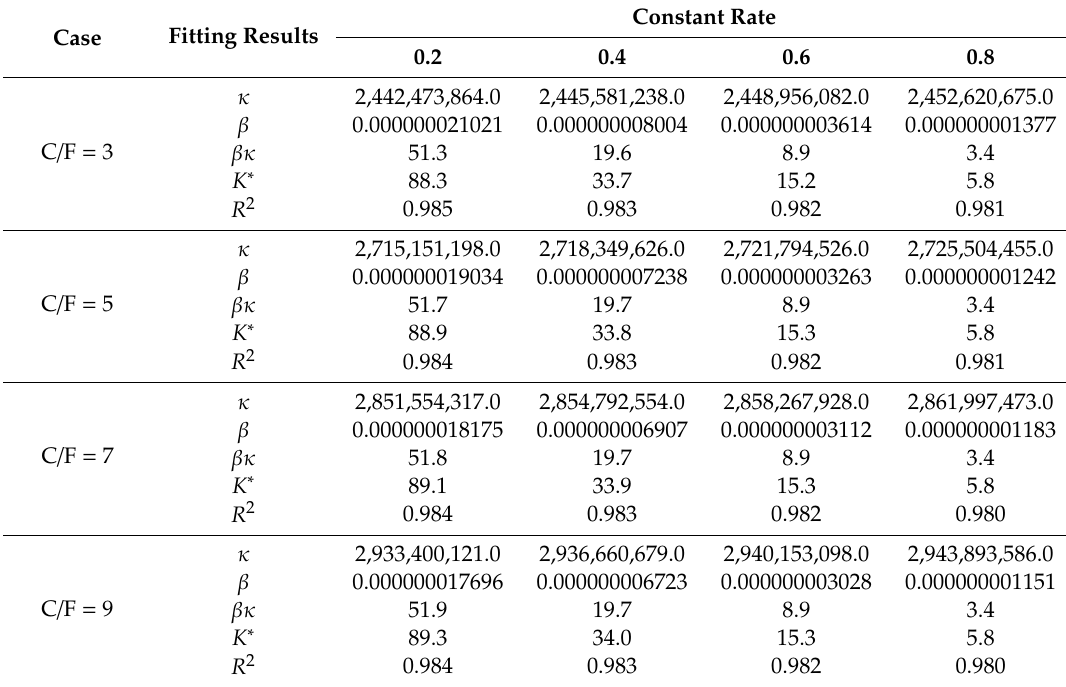
Table 4. Fitting results (parameters κ and β , dam storage coefficient K ∗ and coefficient of determination R 2 ) of the nonlinear reservoir model to the simulated storage–discharge